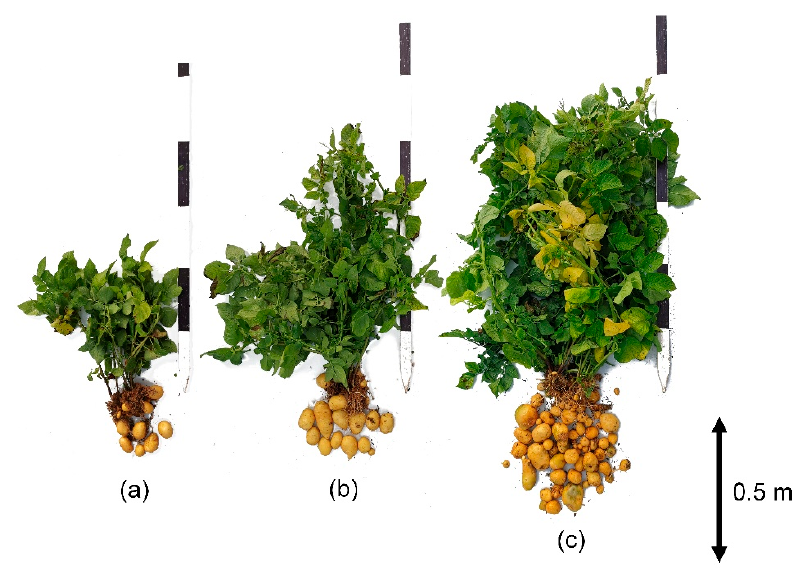
Figure 3. Potato plants (one per group) produced at various fertigation rates: ( a ) 3 min, ( b ) 6 min and ( c ) 20 min.